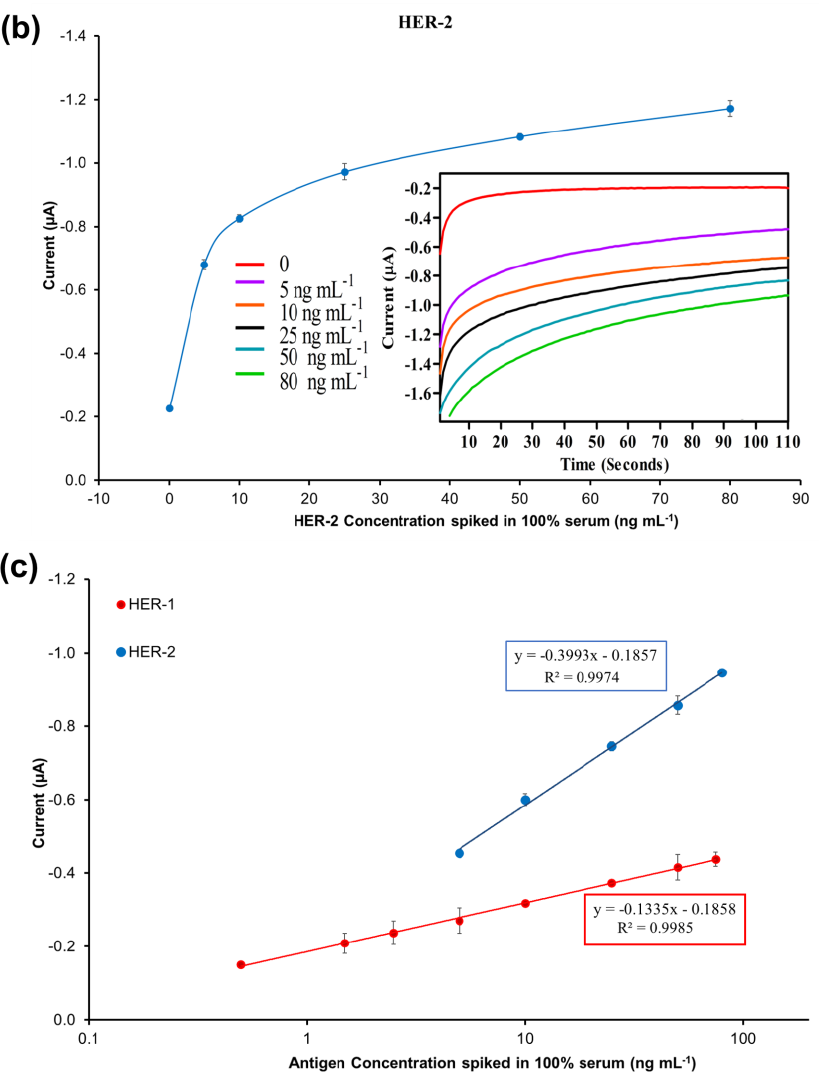
Figure 6. Standardized biosensor response of the optimized immunoassay against increasing concentrations of ( a ) HER-1 antigen (0.5 – 75 ng mL − 1 ); ( b ) HER-2 antigen (5 – 80 ng mL − 1 ) spiked in 100% serum. Embedded graph shows the raw chronoamperometry measurements. ( c ) Linear regression of the assay spiked in serum samples with data taken from Figure 6a,b. Standard deviations were calculated from experiments performed in triplicate ( n = 3).